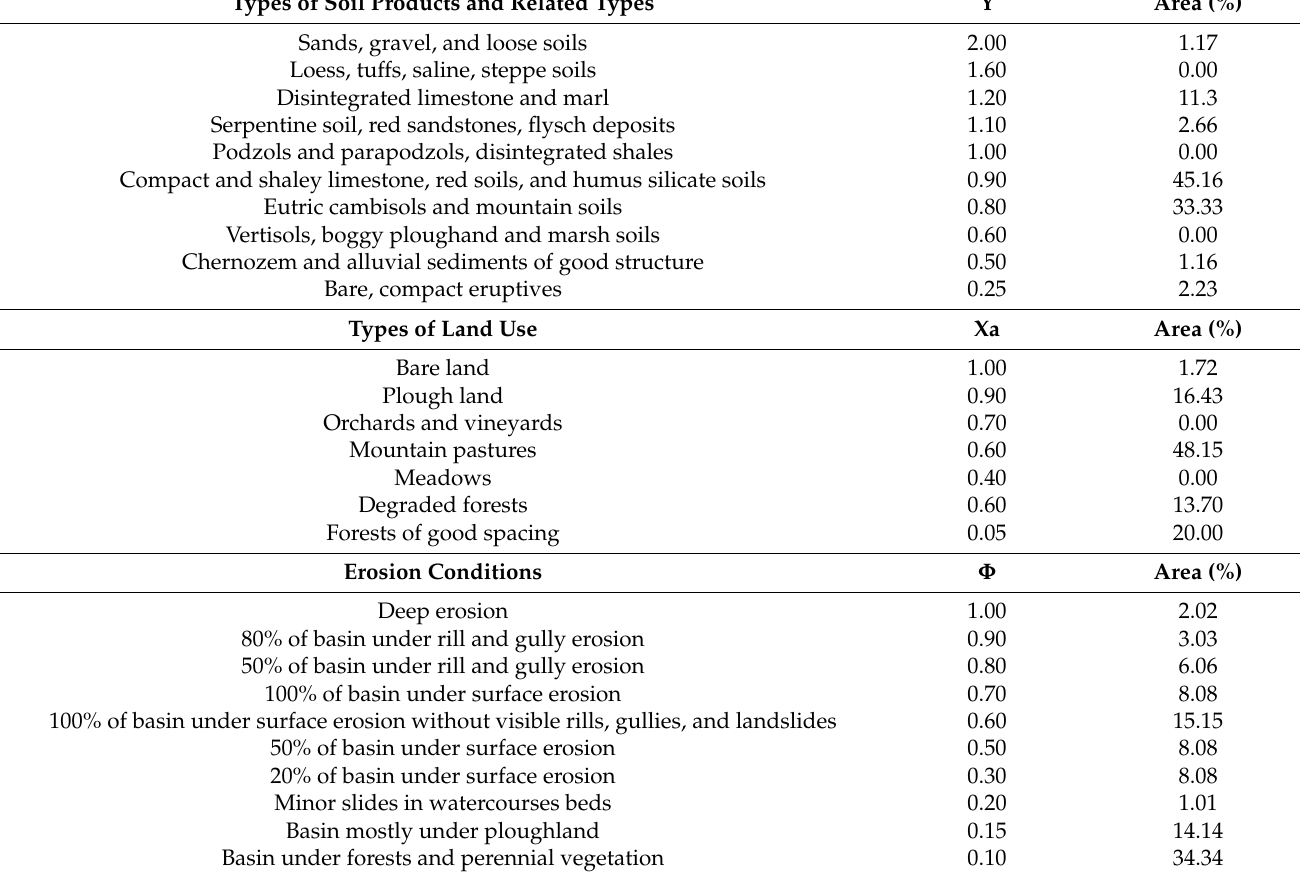
Table 5. The Y, Xa, and Φ coefficients for land use 2014.